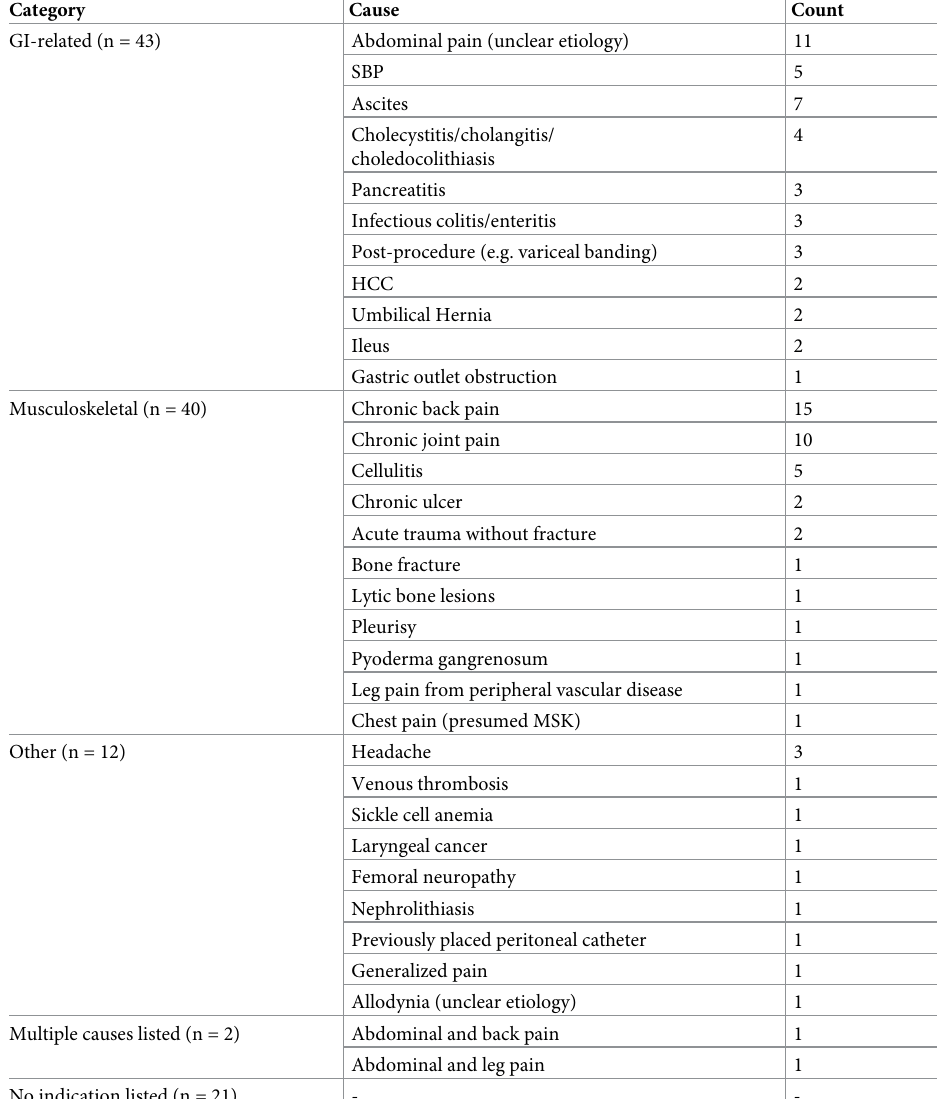
Table 6. Indications for opioid use during